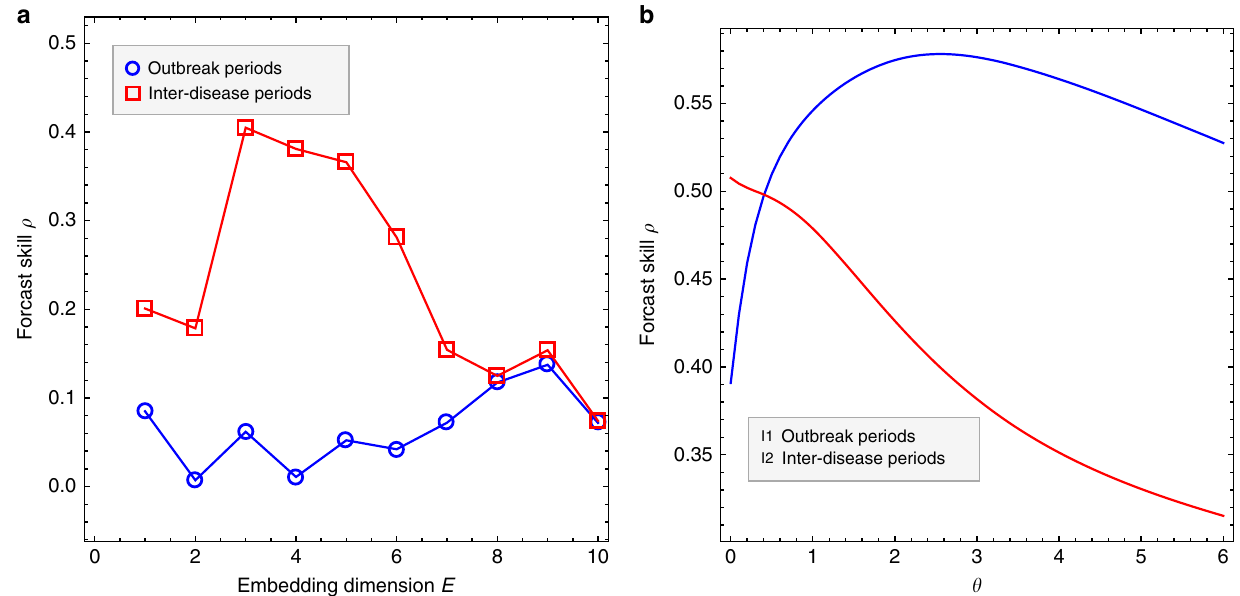
Fig. 2 Empirical dynamical analysis for inter-disease periods and outbreak periods in the time series of dengue incidence in San Juan. a The low optimal embedding dimension 21 of the inter-outbreak period ( E = 3) is consistent with contraction of the dynamics onto stable states, while the outbreak period is higher dimensional ( E = 9). b The S-map test for nonlinearity 20 shows linear equilibrium dynamics for the inter-disease periods and nonlinear dynamics for the outbreak periods, consistent with the hypothesized mixed model set up (see